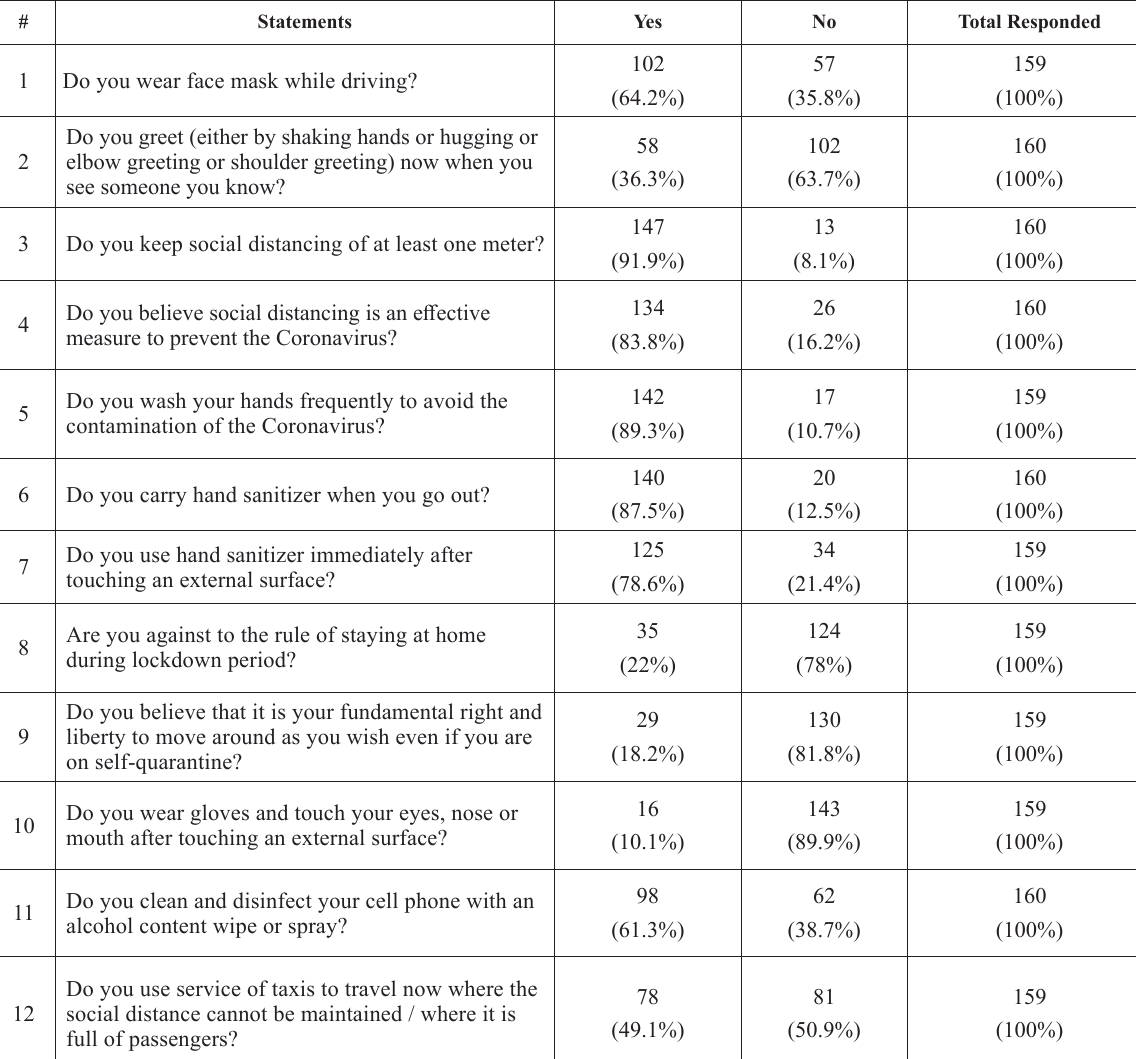
Table 3. Behaviours of people toward COVID-19